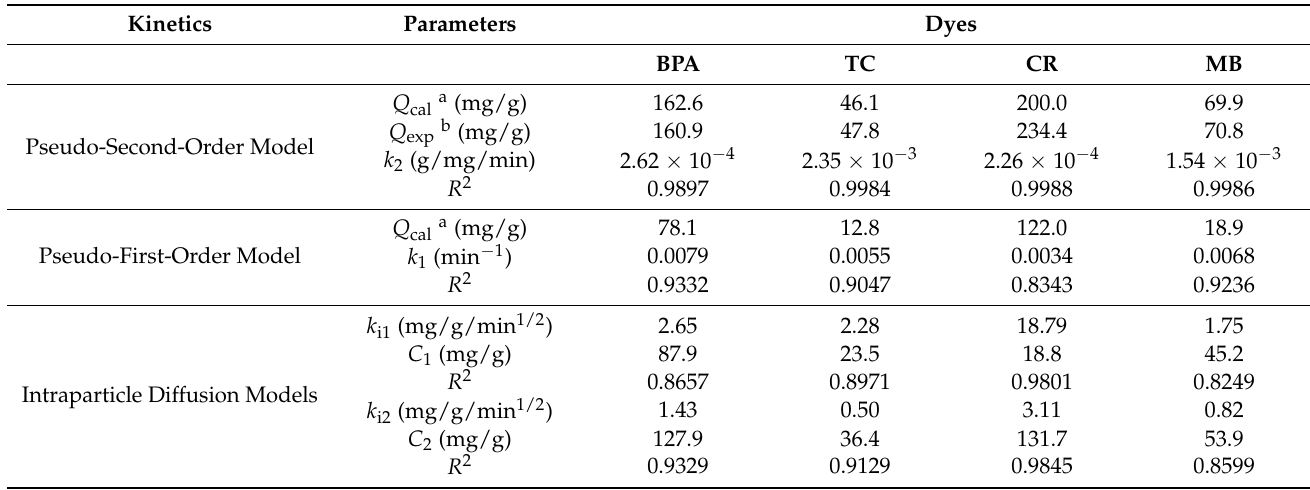
Table 2. Parameters of Pseudo-First-Order, Pseudo-Second-Order, and Intraparticle Diffusion Models.